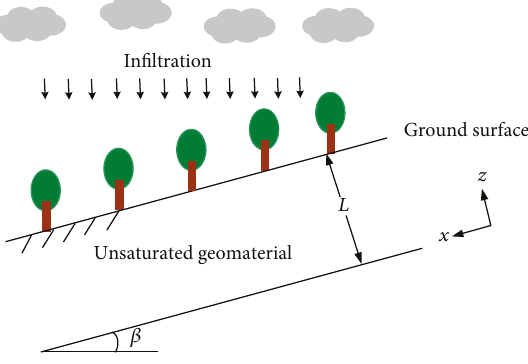
Figure 5: Schematic illustration of homogenous unsaturated inclined slope. Table 1: Unsaturated soil parameters used in the veri fi cation example